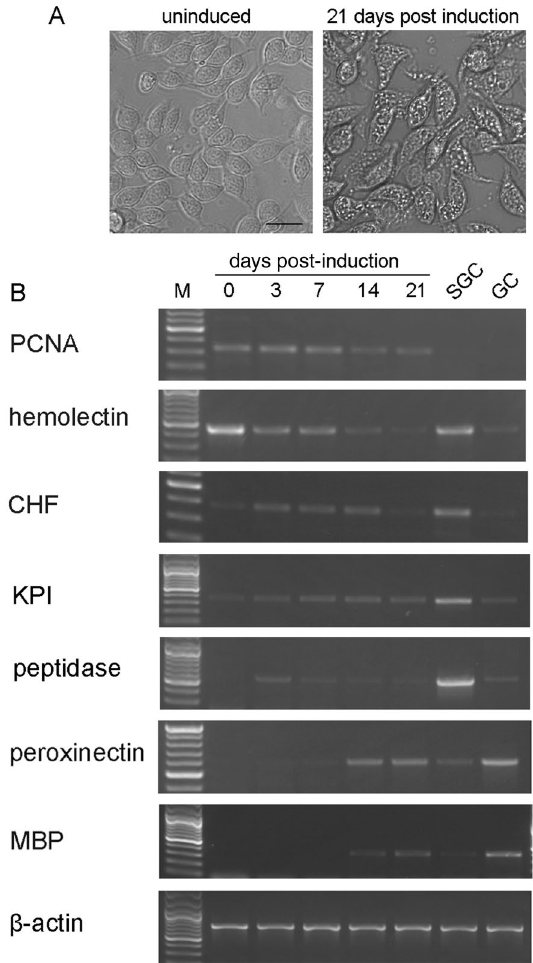
Figure 7. The expression of marker genes indicates a sequential development from HPT cells to SGCs and finally to GCs. The differentiation of GCs from HPT cells was induced in vitro by the addition of crayfish muscle extract. ( A ) Images of uninduced HPT cells and cells induced for 21 days. Bar, 20 μm. ( B ) RNA was extracted from the cells at different times post-induction, and the expression of marker genes was analyzed by RT-PCR. Purified SGCs and GCs were used as the controls. There was a sequential change in the gene expression pattern from undifferentiated HPT cells to SGCs and finally to GCs. The genes analyzed were PCNA (proliferating cell nuclear antigen, HPT cell marker); hemolectin (expressed in HPT cells and SGCs); CHF (crustacean hematopoietic factor, expressed in HPT cells and SGCs); KPI (SGC specific Kazal proteinase inhibitor, SGC marker); peptidase (SGC marker); peroxinectin (GC marker); and MBP (mannose-binding protein, GC marker). β-actin was used as an internal